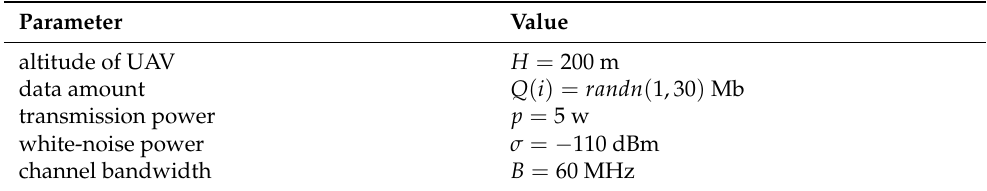
Table 2. Communication model